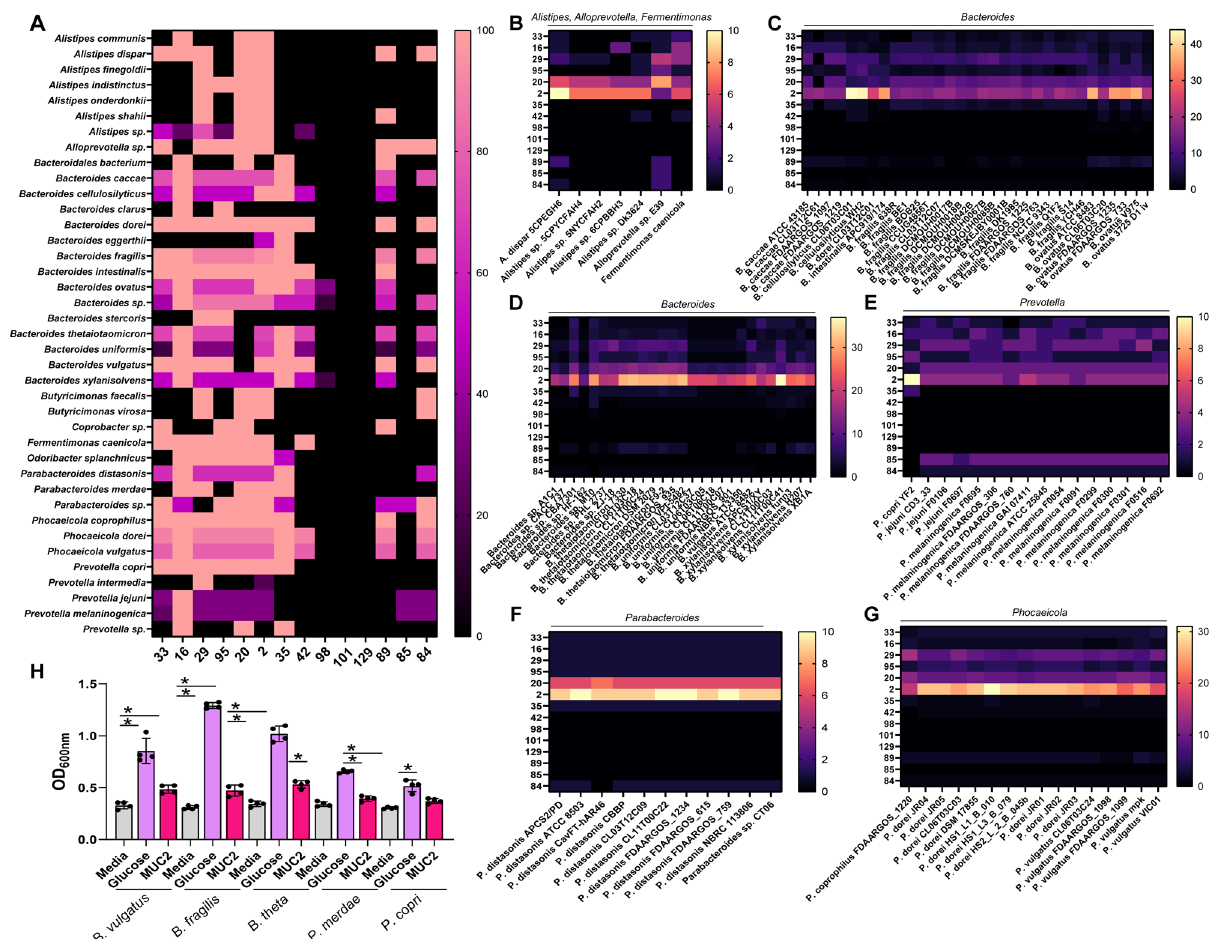
Figure 4. Mucin-related glycosyl hydrolase profiles in the Bacteroidetes phlyum. ( A ) Heat map of the genera within the Bacteroidetes phlyum that have at least one gene copy of each mucin-associated GH 33, 16, 29, 95, 20, 2, 35, 42, 98, 101, 129, 89, 85, and 84. Heat map showing the gene copy number of mucin-associated GHs in the strains of ( B ) Alistipes, Alloprevotella, and Fermenitomonas, ( C ) Bacteroides , specifically B. caccae, B. dorei, B. intestinalis, B. fragilis and B. ovatus, ( D ) Bacteroides, specifically Bacteroides spp., B. thetaiotaomicron, B. uniformis, and B. xylanisolvens, ( E ) Prevotella copri, P. jejuni, and P melaninogenica, ( F ) Parabacteroides and P. distasonis, and ( G ) Phocaeicola coprophilus, P. dorei, and P. vulgatus. ( H ) Growth analysis of Bacteroides vulgatus ATCC 8482 , B. thetaiotaomicron ATCC 29148 , B. fragilis MGH 10513 , Prevotella merdae MGH 10511, and Prevotella copri DSMZ 18205 in a chemically defined media ZMB1 lacking glucose (media control), with glucose (positive control), or lacking glucose and supplemented with 1 mg/mL porcine intestinal MUC2. Growth was measured by examining the optical density at 600 nm (OD 600nm ) after overnight